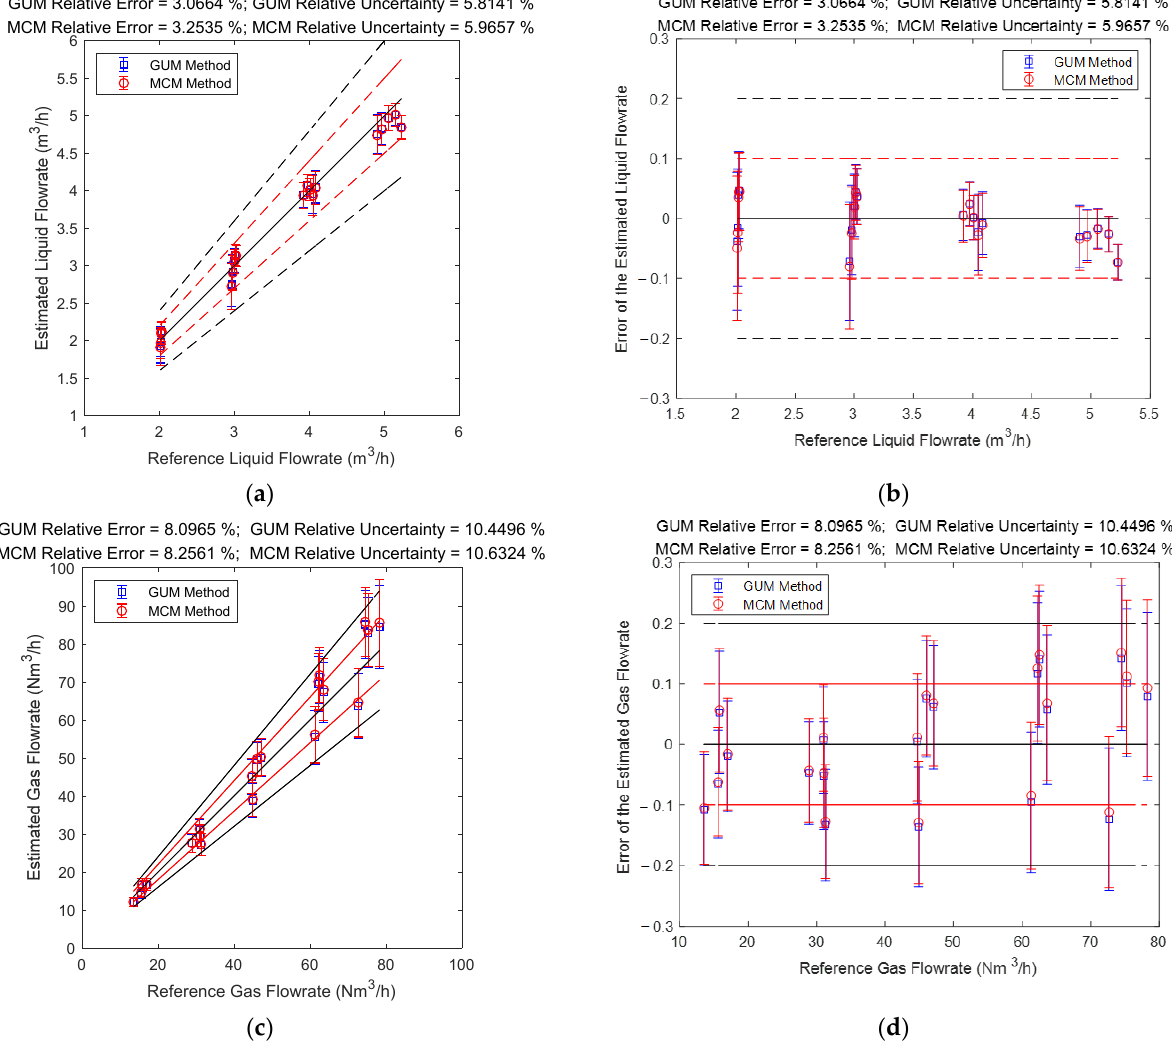
Figure 13. The prediction results of the liquid and gas flowrates of the “DP + Cap” method: ( a ) absolute error of the liquid flowrate; ( b ) absolute error of the liquid flowrate; ( c ) absolute error of the gas flowrate; ( d ) relative error of the gas flowrate. (The central black line denotes the ideal case with zero error, the upper and lower red lines denote the 10% relative error range, and the upper and lower black lines denote the 20% relative error range. The line segments denote the standard uncertainty whereas the distance between the point and the central black line denote the error. More information can be found in Section 2.4.2).